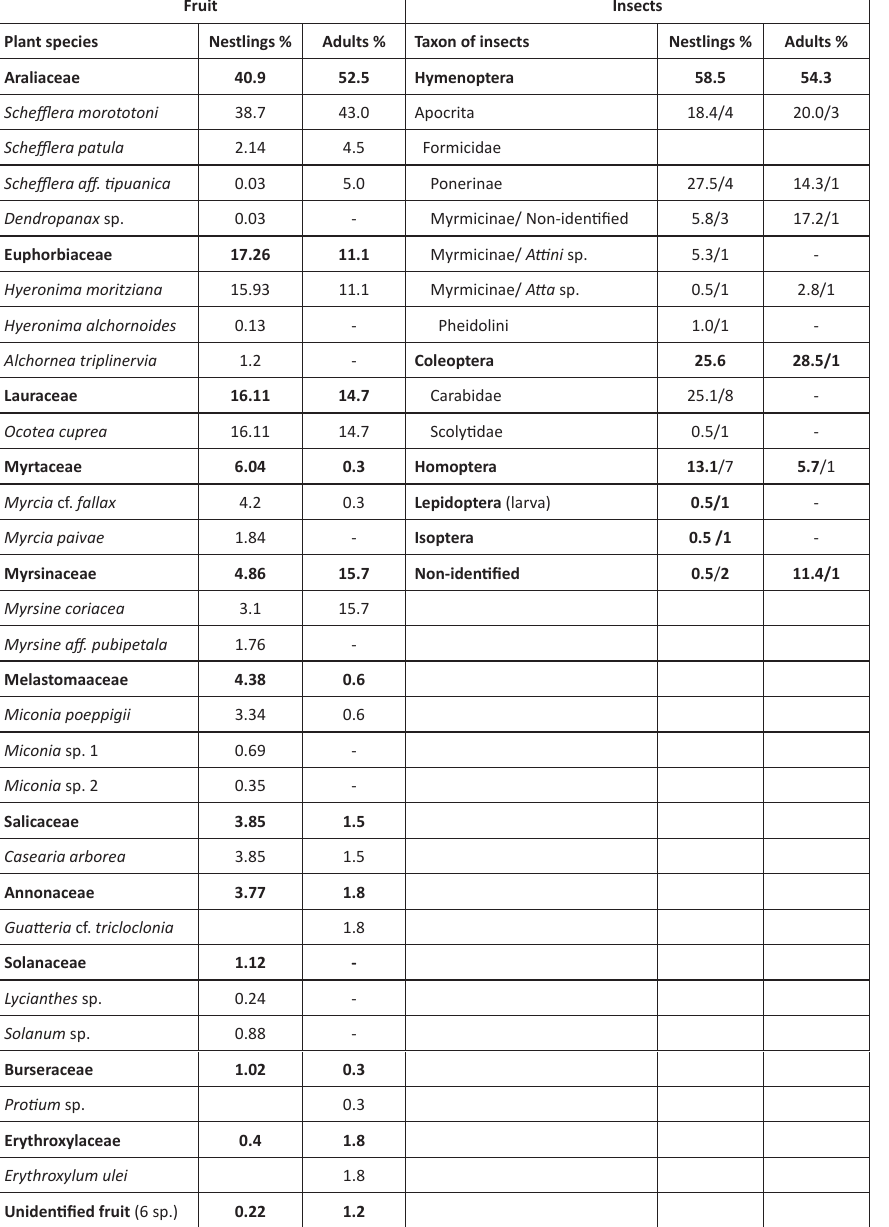
Table 1. Relative frequency of fruit and insects (%) in fecal masses of nestlings (N = 51) and adults (N = 28) of Bolivian Swallow-tailed Cotinga collected from November 2005 to February 2006 at Aten, Bolivia. The number of specimens of insects per taxon is separated by a